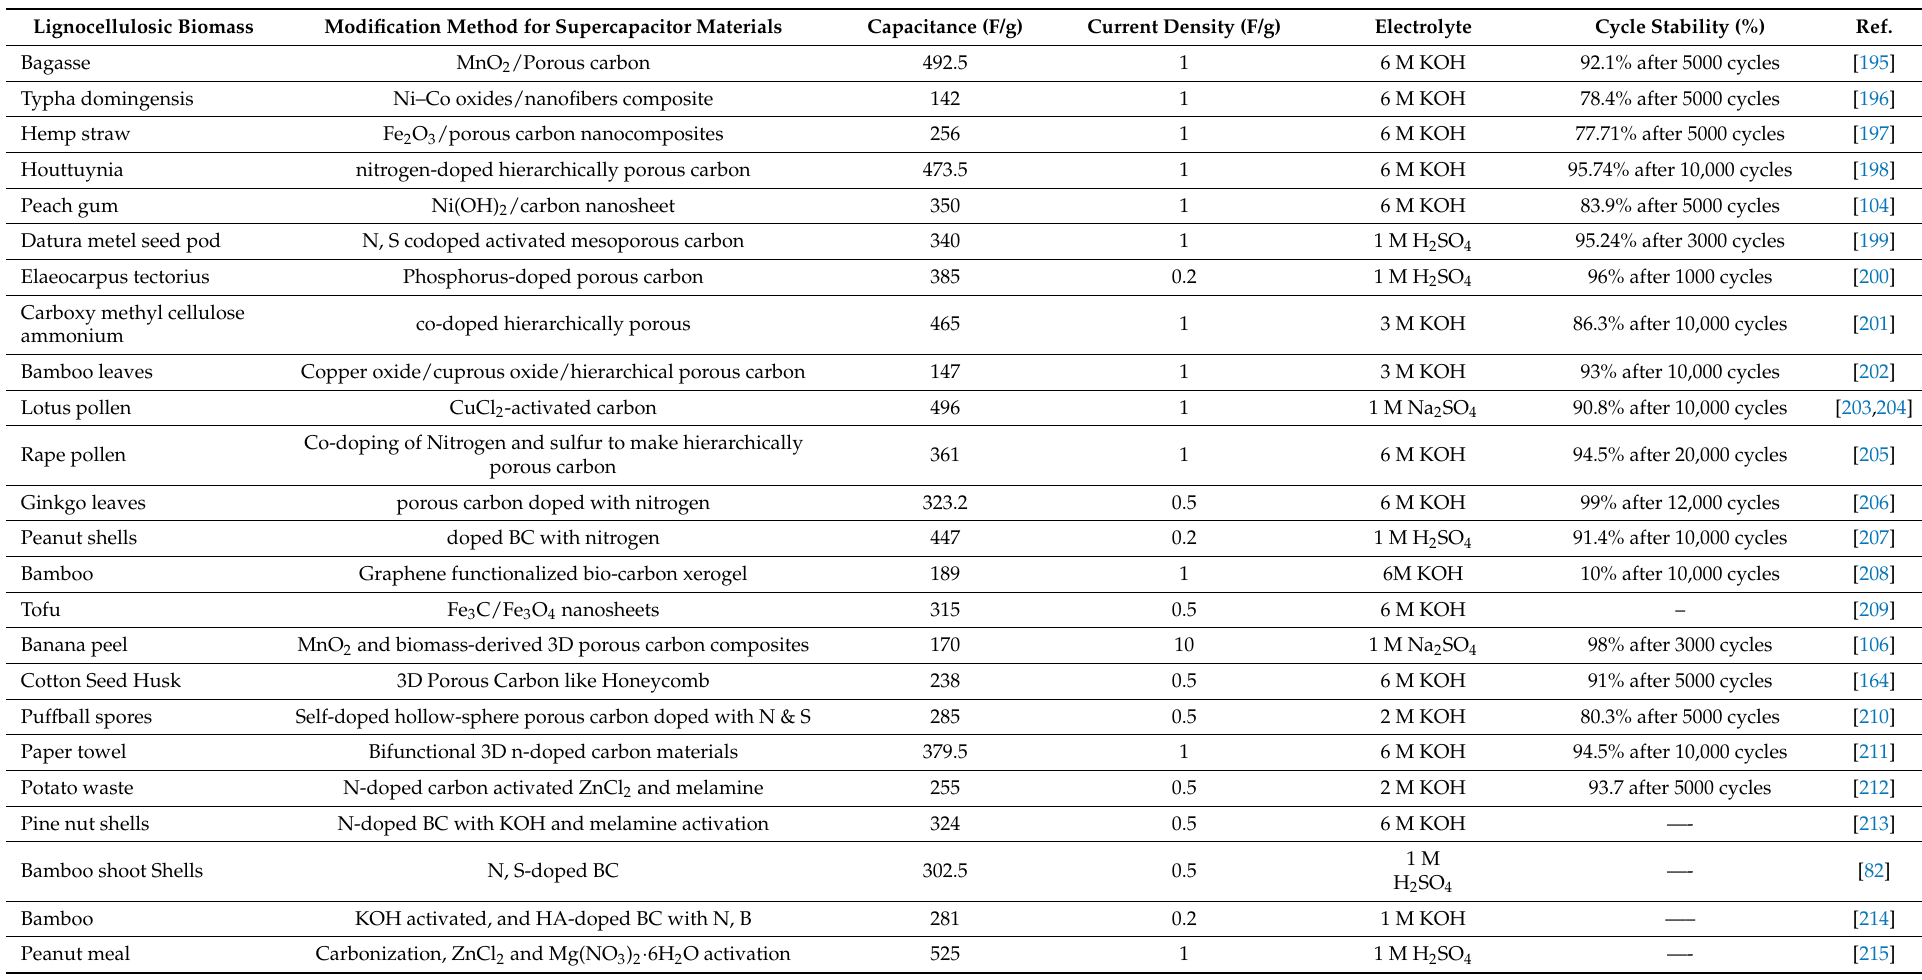
Table 4. Modified BC-based materials via metal loaded and heteroatoms doped BC as an electrode materials for supercapacitor application. Recreated from the references